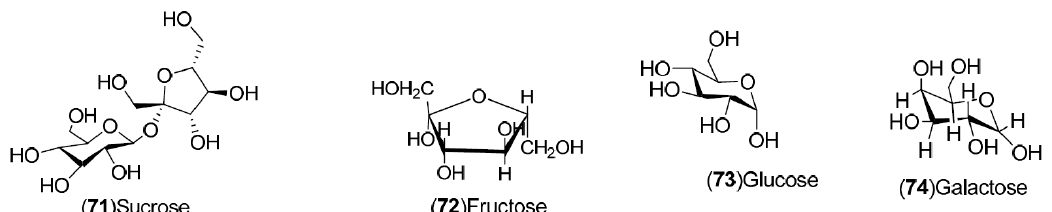
Figure 5. Chemical structures of peptides.